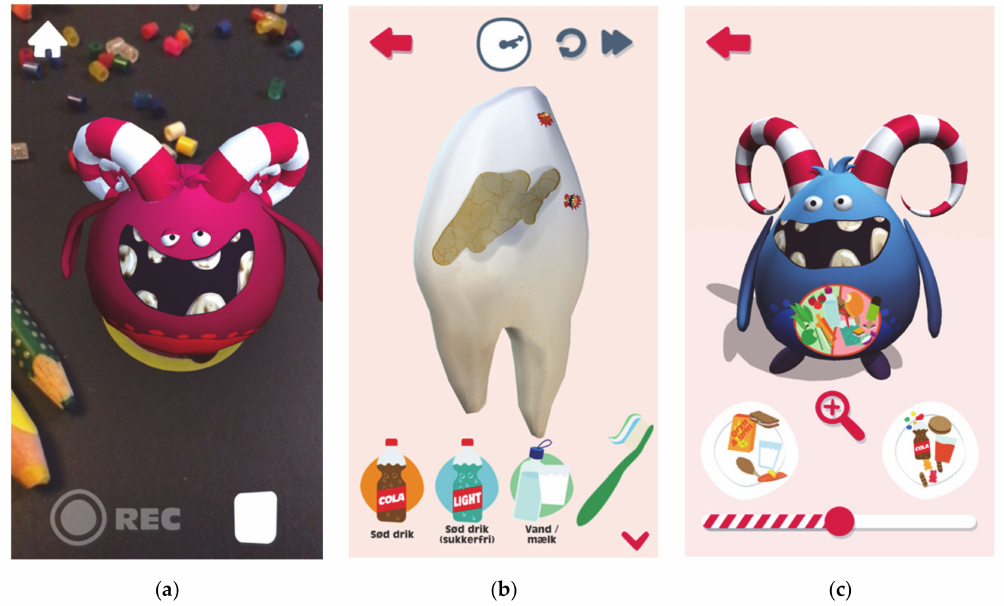
Figure 5. Features of learning app. ( a ) Augmented reality (AR) function wakes a monster when an AR sticker is scanned using a smartphones rear camera; ( b ) a tooth can be exposed to both discretionary drinks and di ff erent food, but you have to brush right away to prevent damage; ( c ) the Monster can be fed with both discretionary food or healthy food, but there is not room for both.